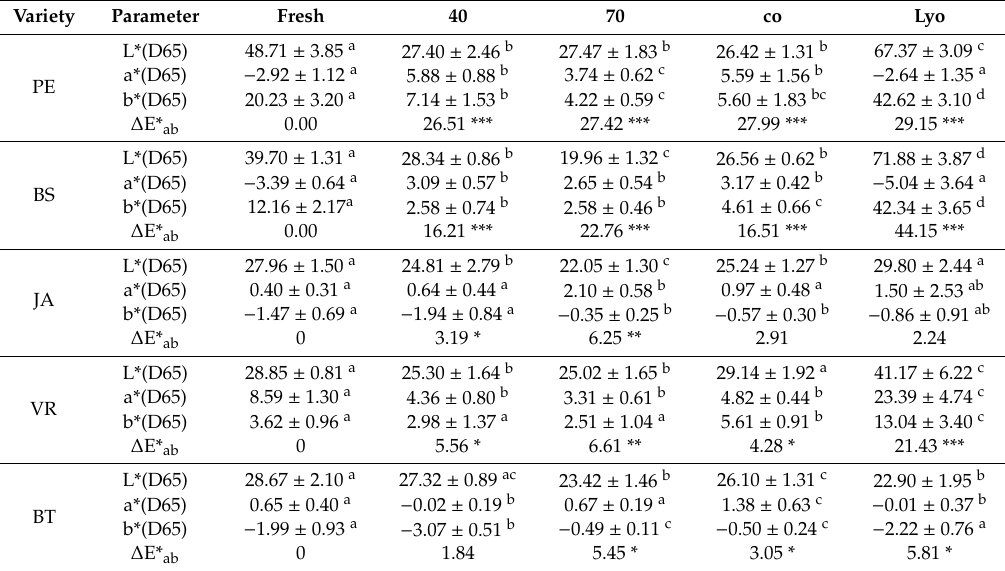
Table 3. Colour determination of fresh and dried grape varieties depending on drying